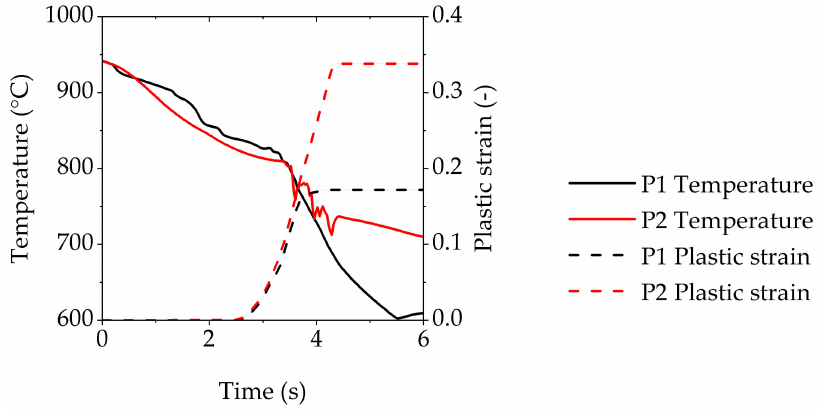
Figure 14. Temperature–plastic strain vs. Time diagram for X46Cr13 alloy after initial austenitization at 1050 ◦ C and immediate transfer in the tool in P1 and P2 according to Figures 12 and 13.